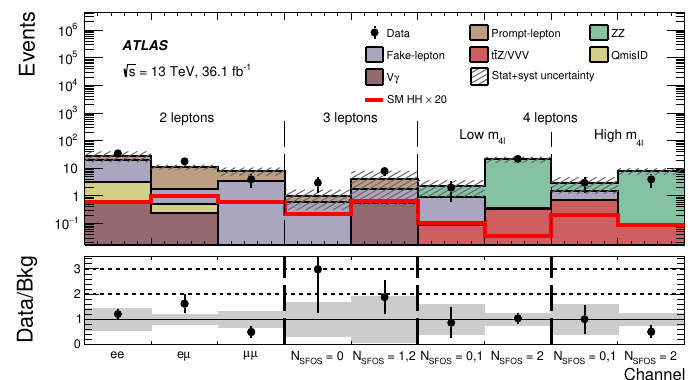
Figure 2 . Expected and observed yields in each channel after all selection criteria for the non- resonant HH production searches. The label N SFOS indicates the number of same-(cid:13)avour, opposite- sign lepton pairs in the channel. Low and high m 4 ‘ indicates m 4 ‘ < 180 GeV and m 4 ‘ > 180 GeV, respectively. The shaded band in the ratio plot shows the systematic uncertainty in the background estimate. The signal is scaled by a factor of